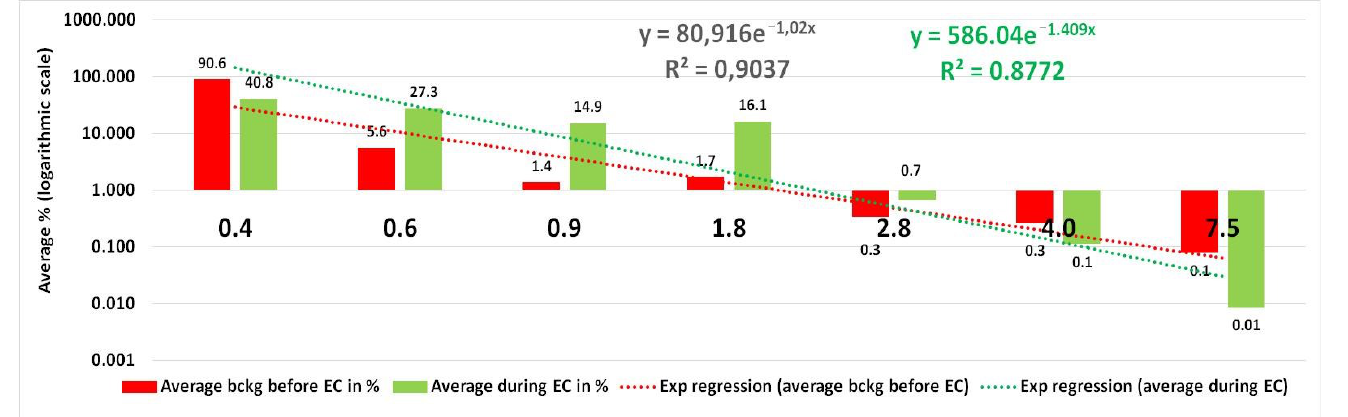
Figure 6. Real-time graph of ECSHA measured in counts/L using “JUUL” ECs, with a sampling time of 10 s. Comparing ECSHA and background size profiles, we found a significant percentage increase in >0.5 (35.8 and 7.72%, respectively), >0.7 (13.5 and 2.75, respectively) and >1.0 (6.2 and 168, respectively). The Pearson correlation was good (R = 0.953), and the Wil-